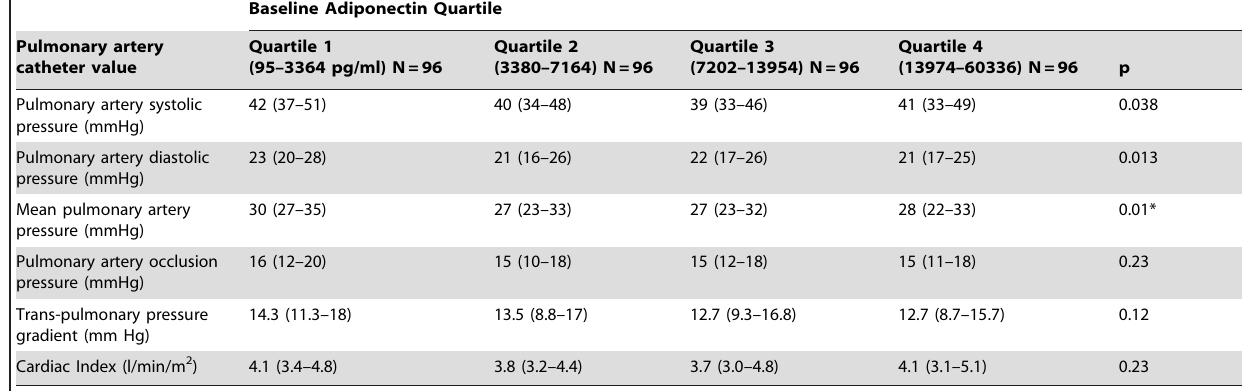
Table 2. Pulmonary artery catheter hemodynamics and adiponectin levels.